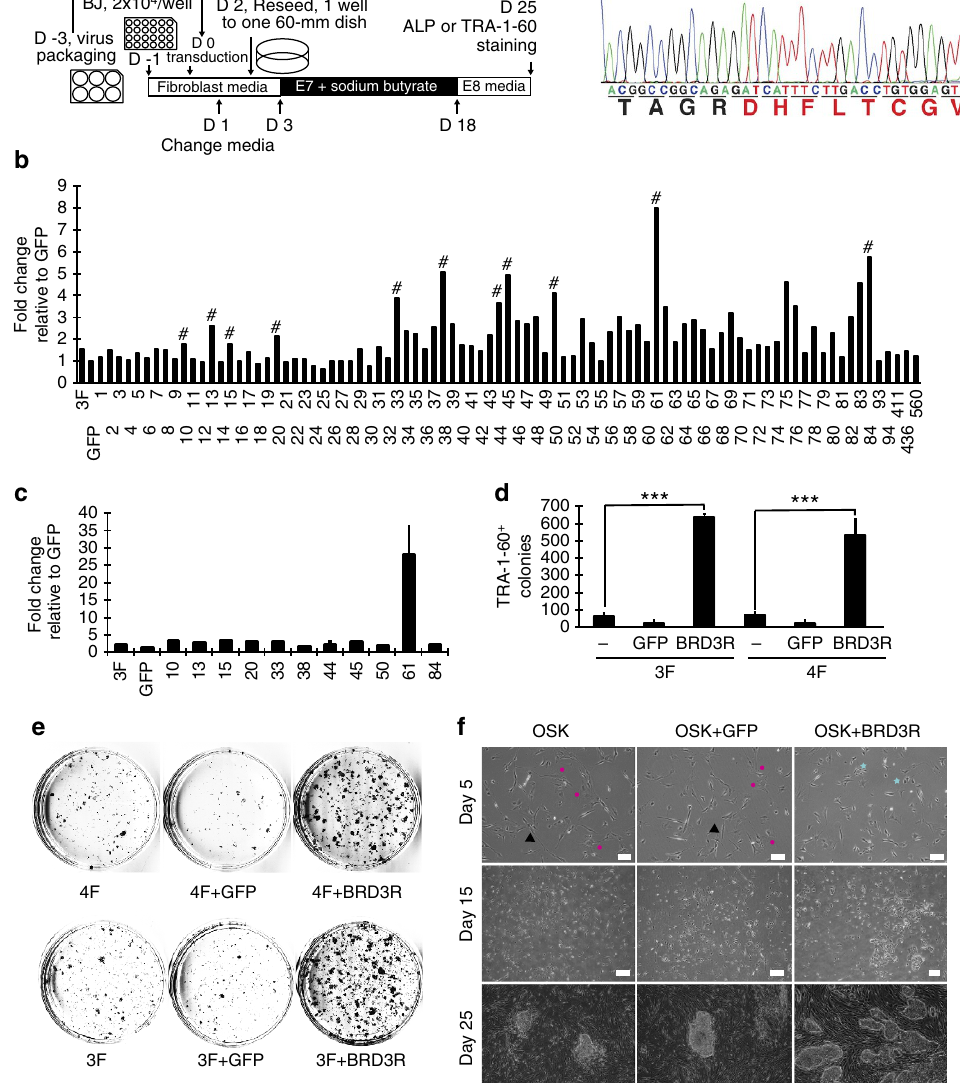
Figure 1 | BRD3R is a robust reprogramming factor. ( a ) Schematic of the screening protocol. D, days. ( b ) Fold changes of ALP þ colonies for the 89 human kinase cDNAs in primary screen as compared with GFP control. #, Genes for the secondary screen. ( c ) Fold change as in b for the 11 candidate genes in the secondary screen. ( d ) Validation of the reprogramming activity of BRD3R as evaluated by number of TRA-1-60 þ colonies ( n ¼ 3; mean ± s.d., *** P o 0.001; t -test). 3F, OCT4, SOX2 and KLF4; 4F, 3F plus MYC. ( e ) Representative images of TRA-1-60 staining for the reprogramming dishes in d . ( f ) Comparison of BRD3R reprogramming with controls at different time points to demonstrate higher numbers of colonies, distinct cell and colony morphologies for BRD3R reprogramming. Turquoise stars, small round cells resembling mitotic cells; Black triangles, typical elongated fibroblast cells; magenta polygons, senescence cells. At this stage, the cell density in each treatment displays no difference. On day 15, the cell densities in areas surrounding reprogramming colonies are still similar, and therefore cells within BRD3R colonies contribute to the increased numbers of cells as seen in Supplementary Fig. 11. Scale bar, 100 m m (upper panel); Scale bar , 200 m m (middle and lower panels). ( g ) Sequencing chromatogram of Clone 61 showing the unique C-terminal 8-aa extension of BRD3R